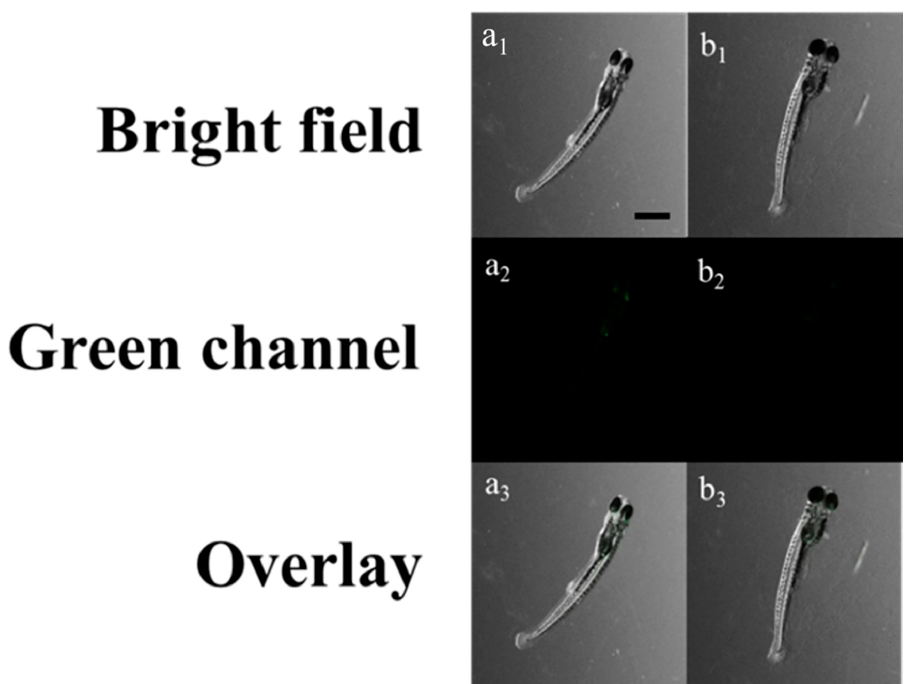
Figure 7. Fluorescence images of zebrafish (6 days old) treated with AFC followed by the addition of ClO − . ( a 1 – a 3 ): AFC only; ( b 1 – b 3 ): AFC with 5 × 10 − 5 M ClO − . [ AFC ] = 5 × 10 − 5 M.